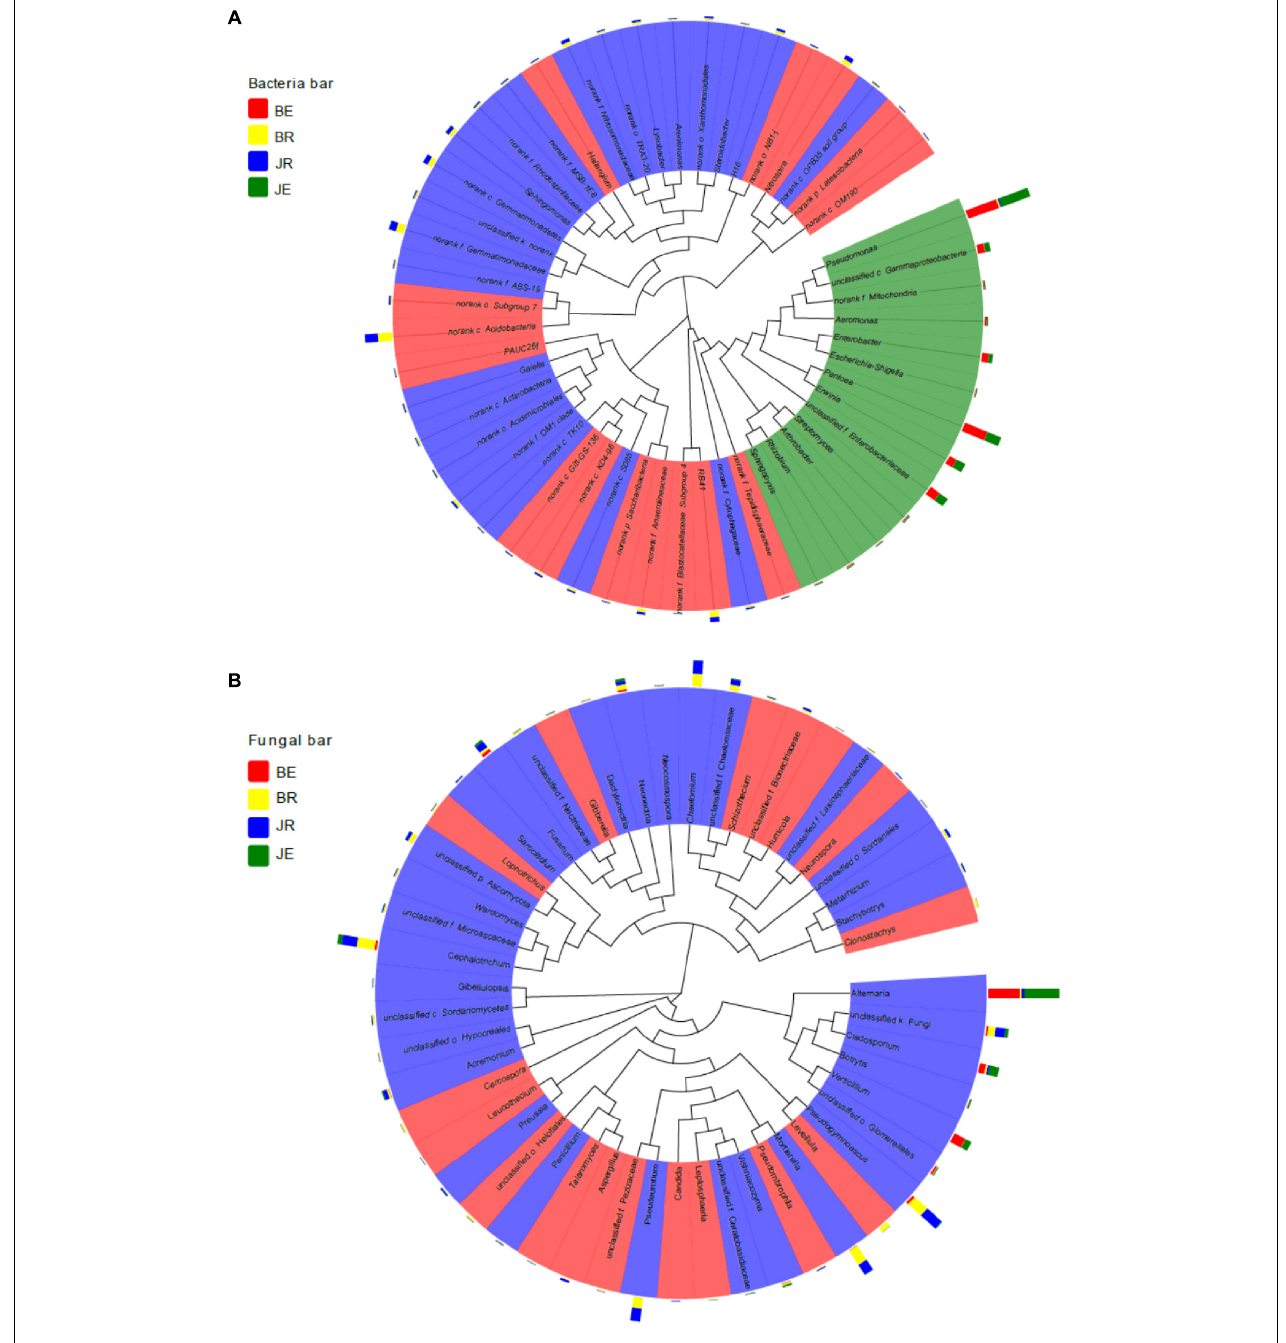
FIGURE 7 | A Phylogenetic tree of the top 50 bacterial (A) and fungal (B) genera and their distributions in the rhizosphere soils and root of cotton with different pathological statuses. The background color of the taxonomic designation represent its classification at the genus level. The bar plot exhibits the relative abundance of the genus in the BE, JE, BR, and JR samples. BE, JE, BR, and JR, respectively, represent endophytic diseased, endophytic healthy, rhizosphere diseased, rhizosphere healthy,